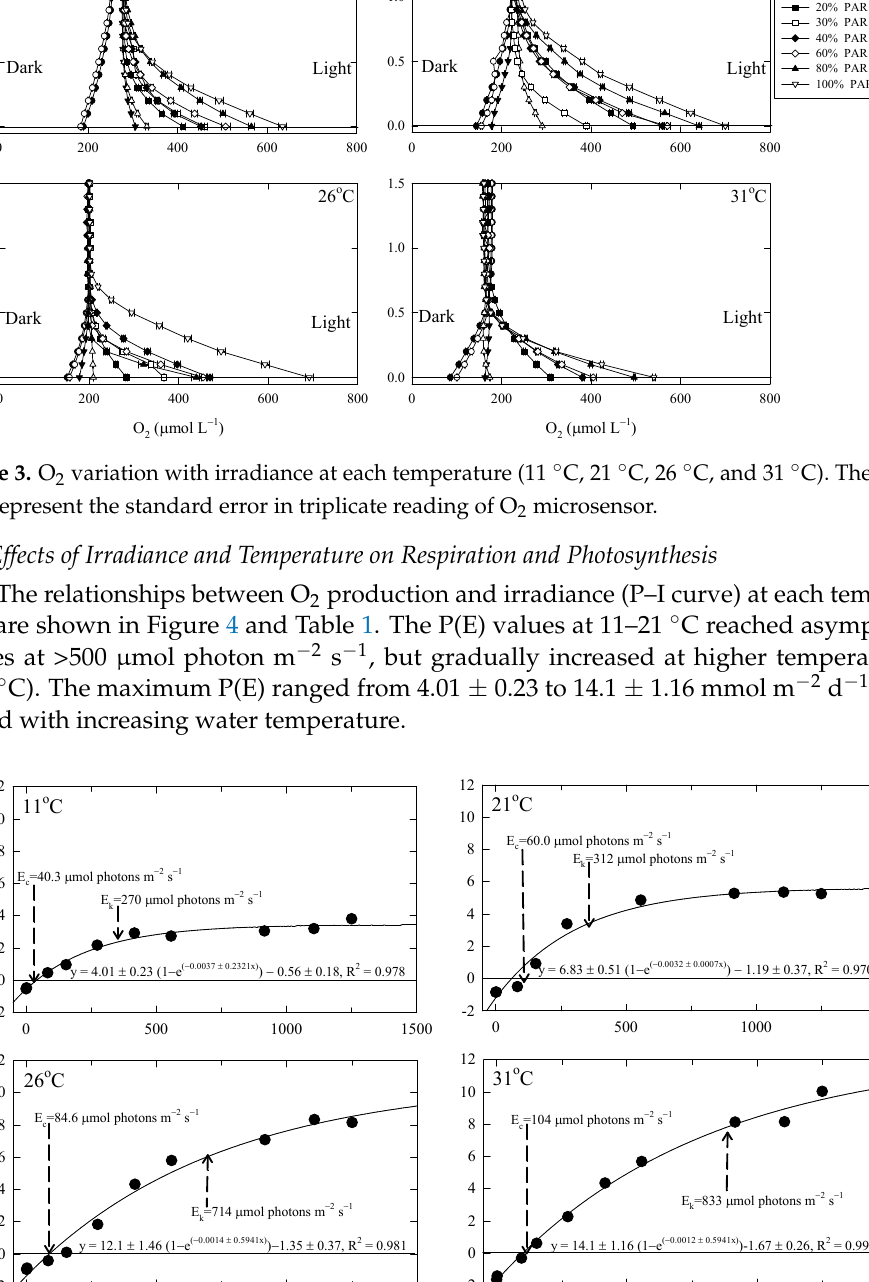
Figure 4. Net O 2 production–irradiance relationships of Pneophyllum fragile at 11–31°C. The solid lines represent the curve fit of the equation P(E) = P max [1 − exp(–αE d /P max )] + R d , where R d is the O 2